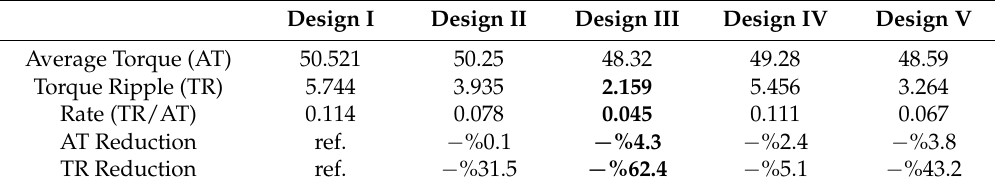
Figure 13. The prototype machine. Table 4. The total comparison of the 3D-FEA results.